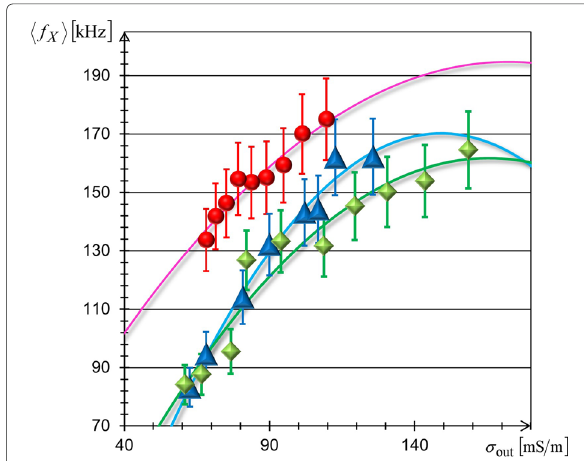
Fig. 6 Conductivity dependences of crossover frequencies. Mean (cid:10) (cid:9) , of TL cells (blue triangles), BL cells (green crossover frequency, f X diamonds), and RB cells (red circles) varying with increase of solution conductivity σ out . The best-fit results of Eq. (15) are delineated by the solid lines